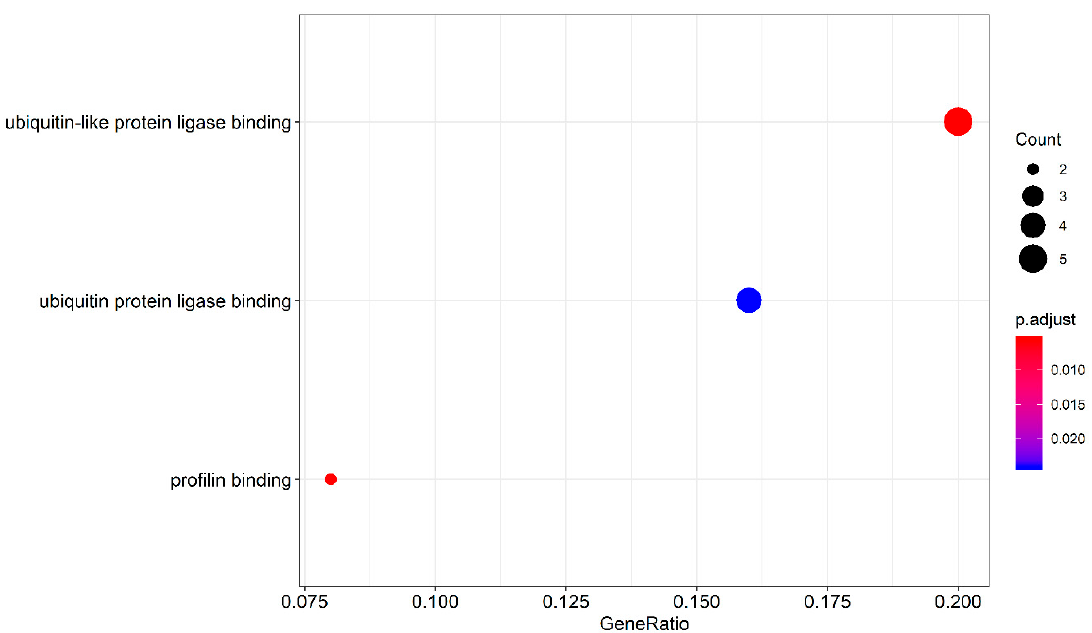
Figure 7. Pathways identified by Gene Ontology (GO) analysis. The genes from survival-associated AS events in GBC were subjected to GO pathway analyses. The dot size stands for the number of the enriched genes, and FDR values are shown by the color scale. FDR: false discovery rate.